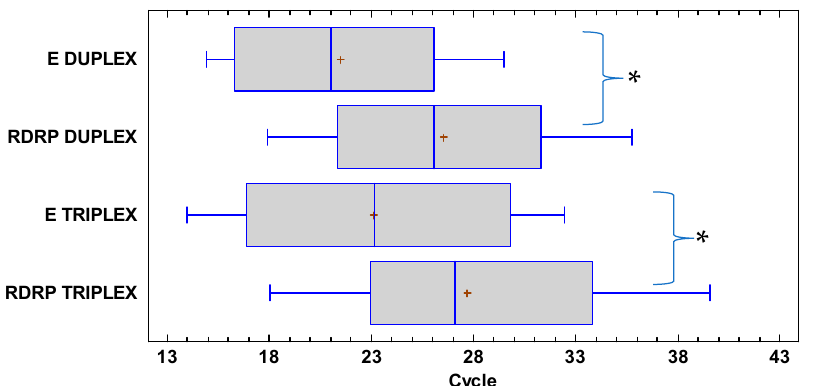
Figure 3. Whisker plot showing the distribution of the median and quartile values distributed between the triplex and duplex RT-qPCR treatments in the detection of the E and RdRp genes. * p < 0.05 between the Ct of both